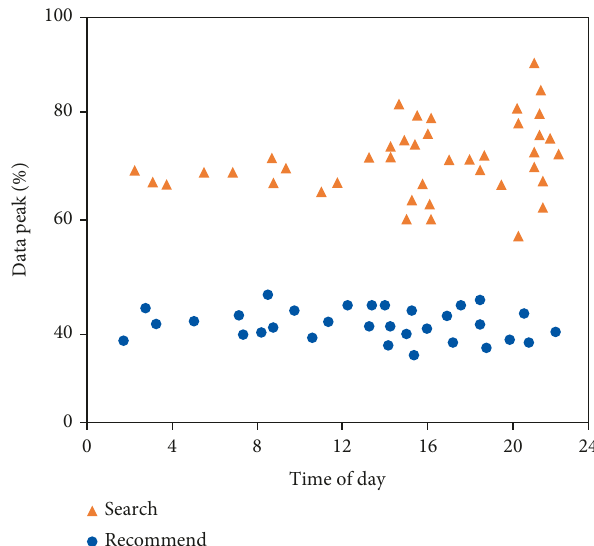
Figure 8: Graph of peak data searched and pushed over an entire day.